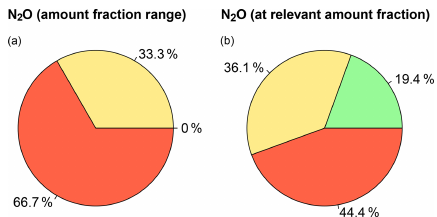
Figure 5. (a) Percentage of N 2 O performance audit results that were for the range of the relevant amount fraction ± 5nmolmol − 1 within the WMO/GAW network compatibility goals (green), the ex- tended network compatibility goals (yellow), or outside the network compatibility goals (red). (b) Same as (a) but at the relevant amount fraction (see text for details).